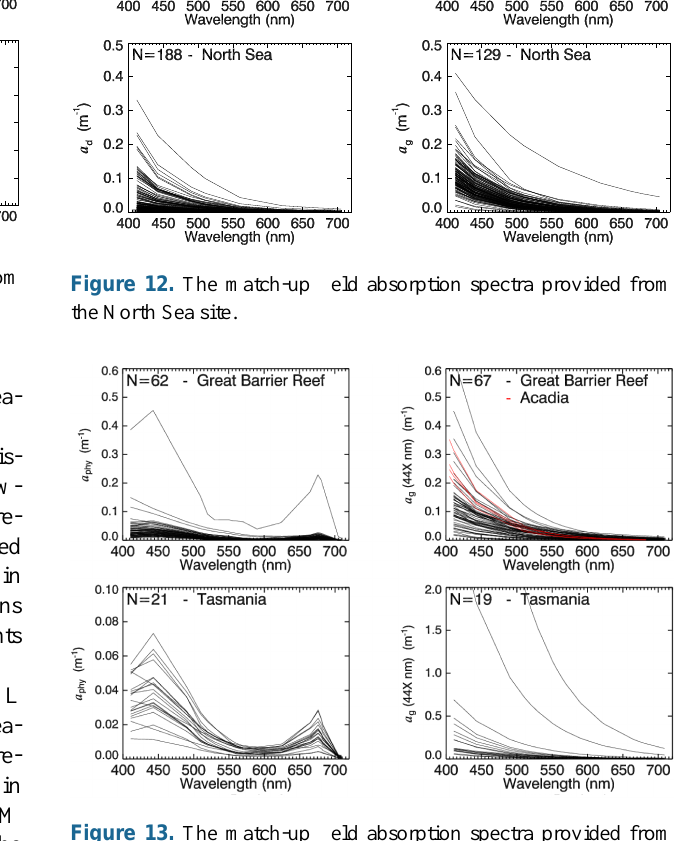
Figure 13. The match-up field absorption spectra provided from the GBR region and Acadia (upper panel) and Tasmania (bottom)